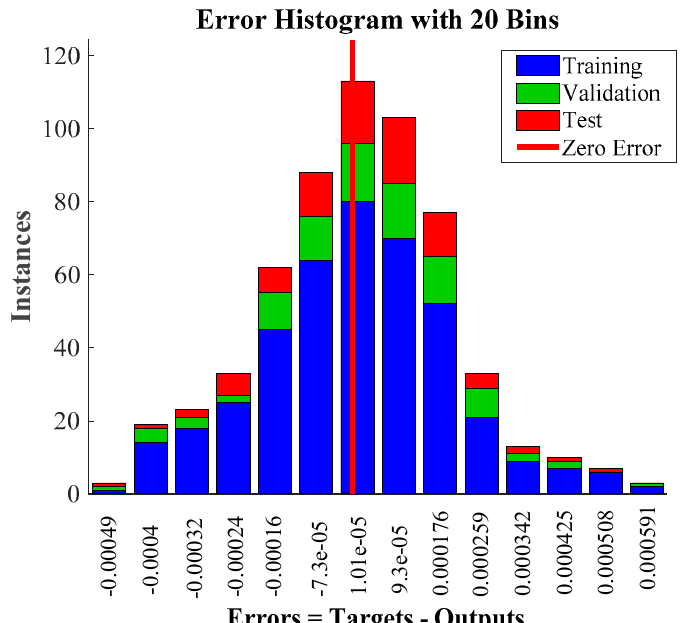
Figure 11. Error analysis of the ML algorithm.